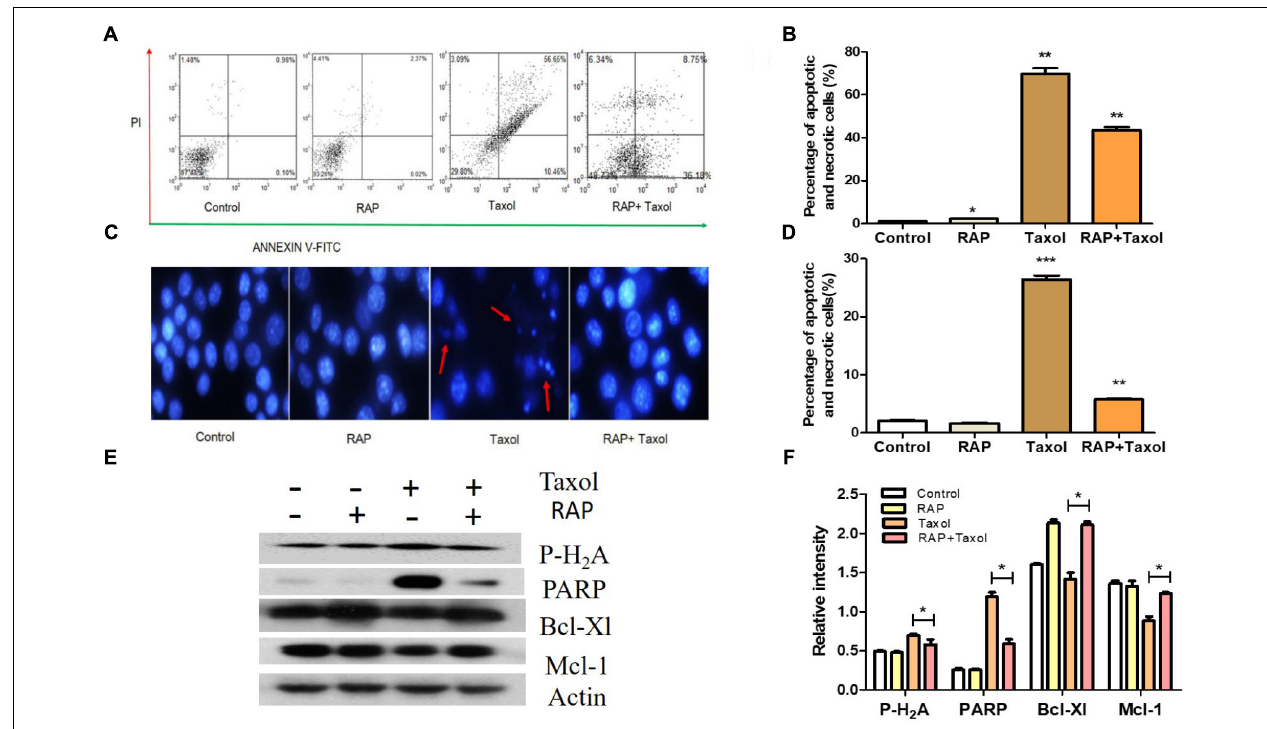
FIGURE 4 | Apoptosis of RAW 264.7 cells treated by RAP (50 µ g/mL) with/without Taxol (10 µ M). (A) Apoptotic effect of RAP with/without Taxol on RAW 264.7 cells detected by flow cytometry; (B) Statistical analysis of apoptotic effect of RAP with/without Taxol detected by flow cytometry; (C) Apoptosis that assessed by Hoechst 33342 staining: red arrow showed some of the typical “apoptotic bodies.” (D) Statistical analysis of apoptotic effect of RAP with/without Taxol detected by Hoechst staining; (E) Western blotting analysis of Phospho-Histone H2A. X (MW: 15 kDa), PARP (full length, MW: 116 kDa), Bcl-Xl (MW: 30 kDa) and Mcl-1 (MW: 35 kDa); (F) Quantitative analysis of Phospho-Histone H2A. X, PARP, Bcl-Xl, and Mcl-1 ( ∗ p < 0.05 compared with Taxol alone group). Data are presented as mean ± SD. Compared with the control group. ∗ p < 0.05, ∗∗ p < 0.01, and ∗∗∗ p < 0.001.